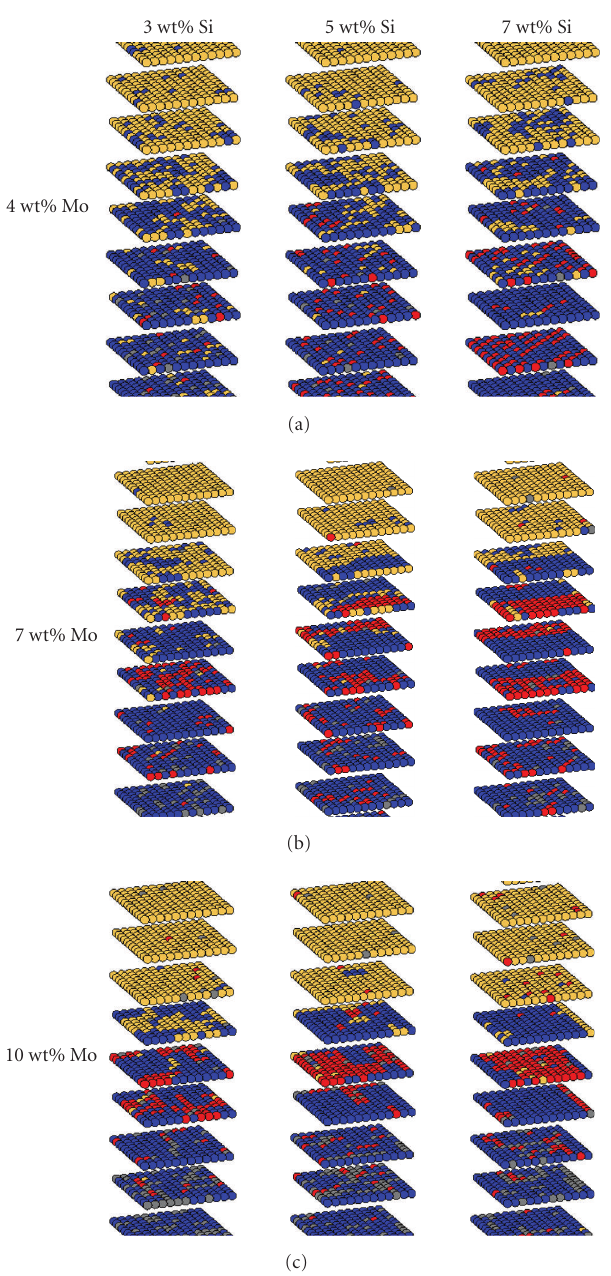
Figure 7: Equilibrium state of the computational cell at T = 450 K for (from left to right) 3, 5, and 7wt% Si and for 4, 7, and 10wt% Mo. Al, Si, U, and Mo atoms are denoted with yellow, red, blue, and grey circles, respectively. The simulations show that the Si stopping power is due to the interplay between Si and Mo and not only to Si additions. The original location of the interface (at the onset of the simulation) corresponds to the middle of each